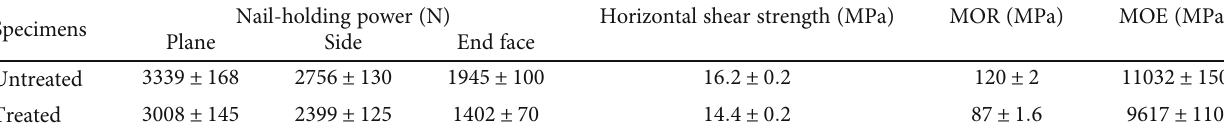
Table 4: Results of bamboo scrimber ’ s mechanical properties after the boiling-testing treatment ( mean ± standard deviation ).